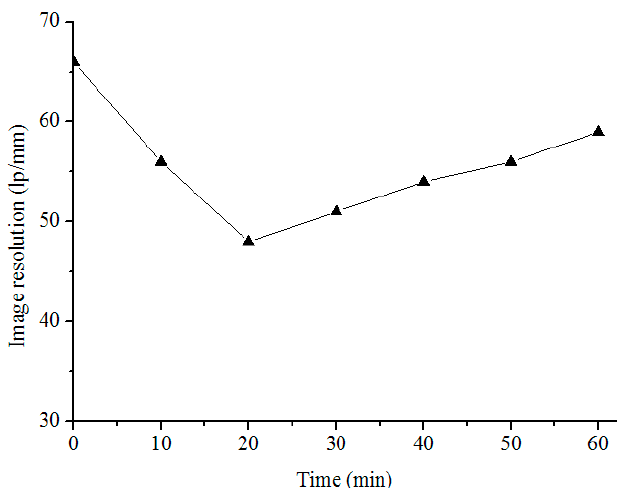
Figure 8. Temperature changes of the primary mirror and the secondary mirror during the test.